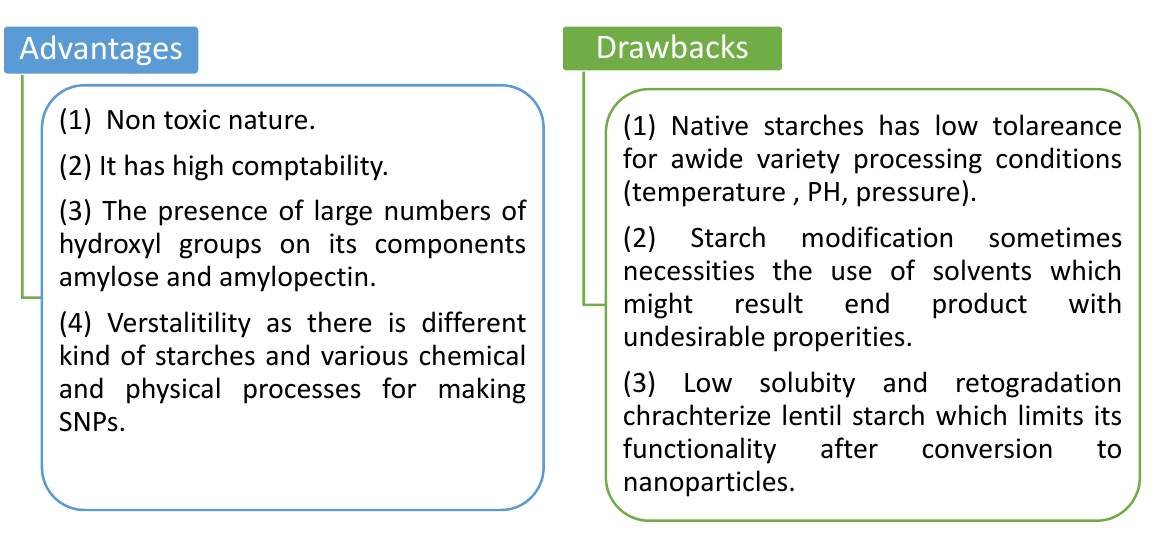
Figure 2. Advantages and drawbacks for preparation of starch as nanoparticles (SNPs).